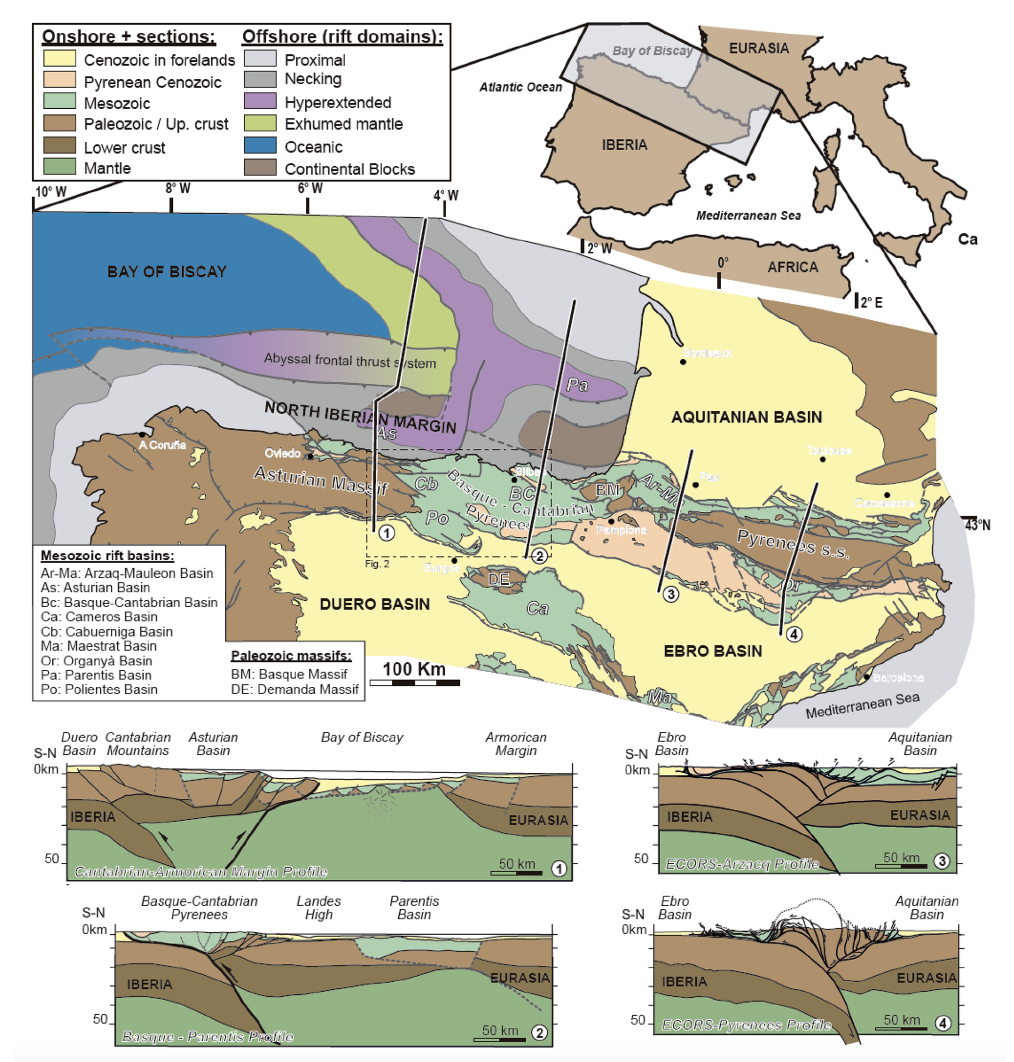
Figure 1. Structural map of the Pyrenean orogen and surrounding areas with crustal cross-sections depicting the main along-strike structural changes. Rift domains are also mapped offshore. (1) Asturian Massif–Armorican Margin (Cadenas et al., 2018); (2) Basque–Cantabrian Pyrenees–Parentis (Ferrer et al., 2008 and Roca et al., 2011); (3) ECORS-Arzaq (Teixell, 1998); and (4) ECORS–Pyrenees (Muñoz,